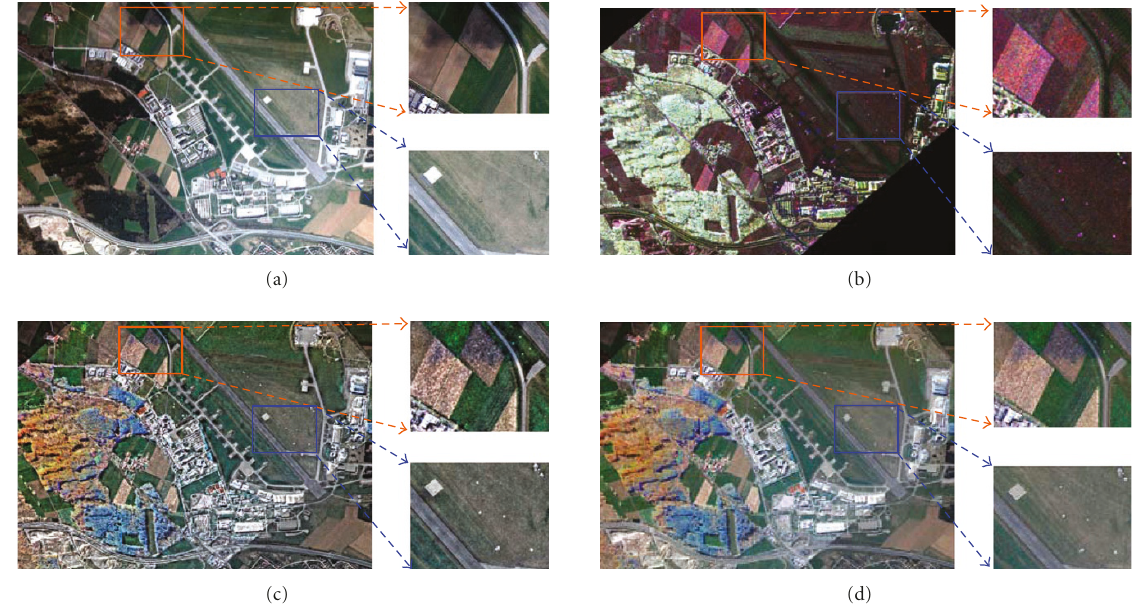
Figure 14: (a) Airborne optical image and its two small cuts. (b) L-band polarimetric SAR image. (c) Fusion results when the intensity components are fused with wavelet fusion. (d) Fusion results based on multi-channel multi-multi and turbo iterative.